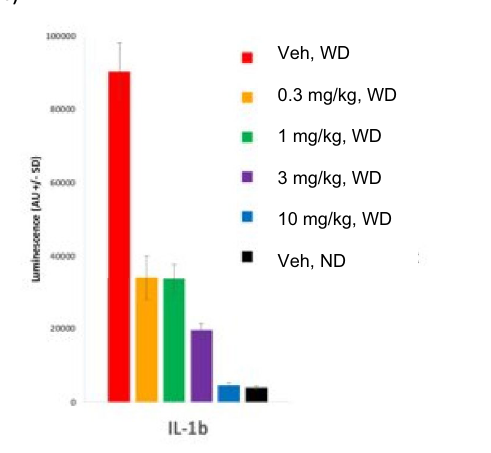
Figure 2. FASN inhibition prevents development of liver steatosis and fibrosis in a preventative NASH diet induced model. ( a ) Effect of FASNi on fibrosis and lipid accumulation. Liver sections at the end of study stained with Mason’s Trichrome or adipophilin, from vehicle or TVB-3664 (3 mg/kg) treated animals on a form of WD, or vehicle treated animals on a normal diet. Representative examples are shown. The scoring per animal is provided in Supplementary Table S1. ( b ) Histological scoring results of H&Estained liver sections. The mean of 5 animals is indicated by horizontal line. Scoring system: 0 (normal), 1 (minimal), 2 (mild), 3 (moderate), 4 (marked). The scoring per animal is provided in Supplementary Table S2. ( c ) IL-1β levels measured from serum collected at the end of the treatment period from vehicle or TVB-3664 treated